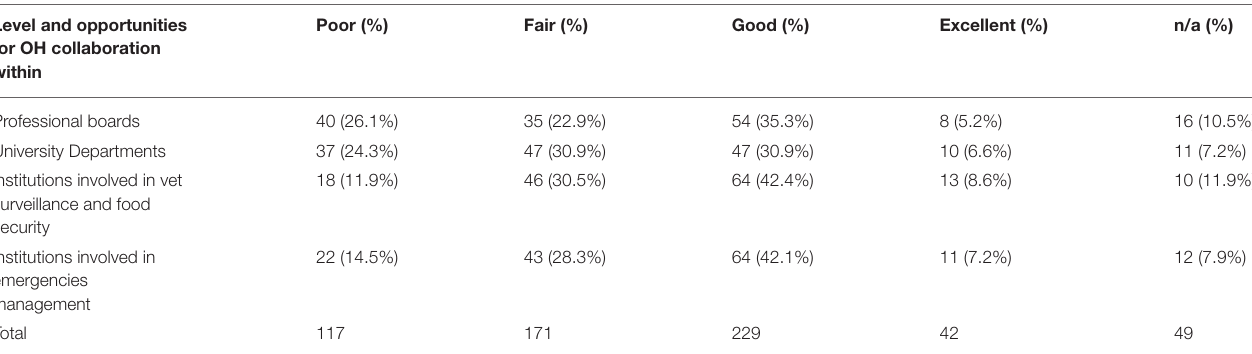
TABLE 2 | Level and opportunities for OH collaboration at different institutional and/or professional levels. Level and opportunities for OH